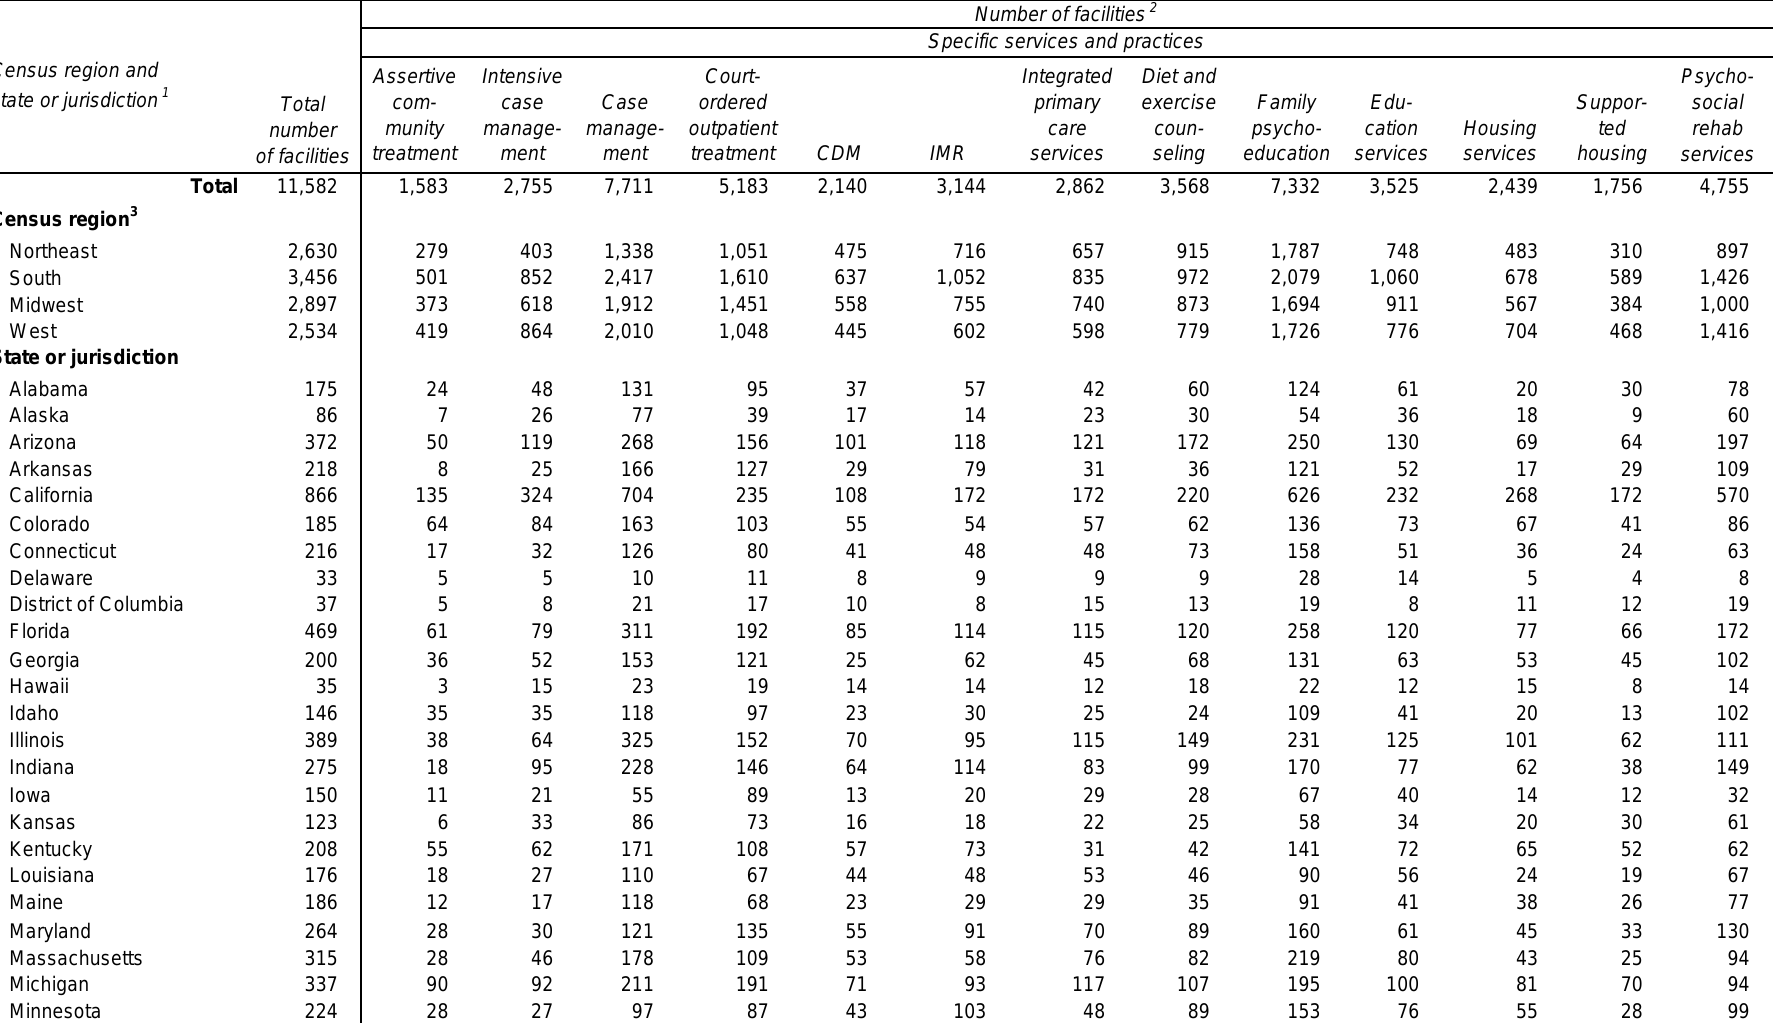
Table 3.8a. Mental health treatment facilities offering specific services and practices, by Census region and state or jurisdiction: Number,